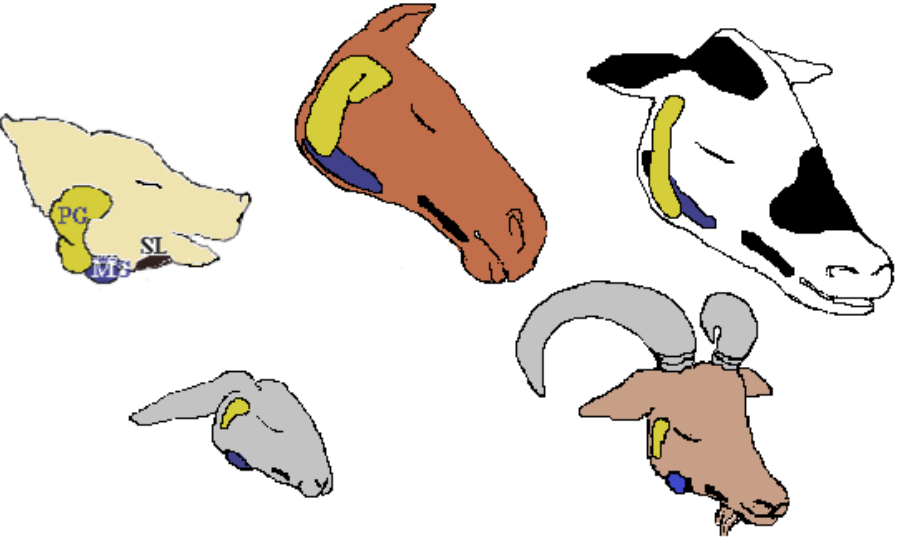
Figure 1. Anatomical topography of major salivary glands in some domestic animal species (clockwise: horse, cattle, goat, rabbit, and pig). Salivary glands are schematically reported with different colours in the region of the head, following the comparative extension of the glands: parotid glands (PG, in yellow), mandibular glands (MG, in blue), and sublingual glands (SL, in black). Secretions of the different pairs of major salivary glands differ in composition according to animal species and the species–specific capability to cope with a variety of feeds, nutrients, and secondary metabolites in the natural diet.